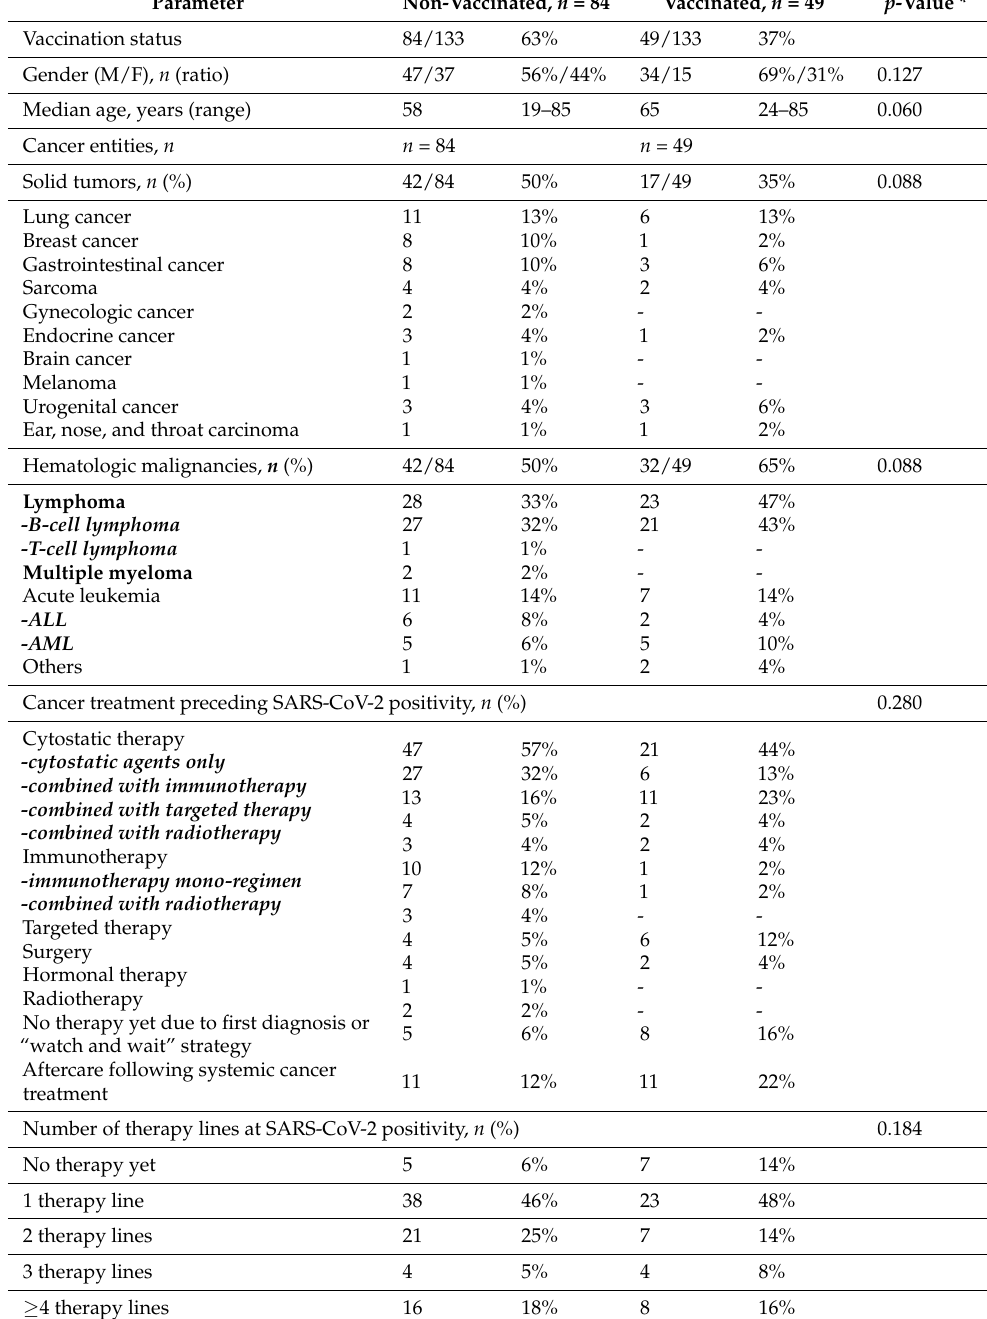
in Supplementary Table S1. In total, 77% ( n = 37/49) of the vaccinated patients had received mRNA-based COVID-19 vaccines. Another 10% ( n = 5/10) had either vector- followed by mRNA-based (8%) or vector-based (2%) vaccines only. Of the remaining cases, 11% ( n = 6/49) were double-vaccinated but lacked data on vaccine type documented in medical records. One patient (2%) received Ad26.COV2.S only one time. Seventeen vaccinated patients (35%) had received a third, mRNA-based, vaccine. The median time from the last vaccination to SARS-CoV-19 detection was 129 days. Table 1. Clinical characteristics of 133 cancer patients at the time of SARS-CoV-2 infection. M, male; F, female; n, number; ALL, acute lymphoblastic leukemia; AML, acute myeloid leukemia; PNH, parox- ysmal nocturnal hemoglobinuria; ITP, immune thrombocytopenia; MDS, myelodysplastic syndrome. Parameter Non-Vaccinated, n = 84 Vaccinated, n = 49 p -Value * Vaccination status 84/133 63% 49/133 37% Gender (M/F), n (ratio) 47/37 56%/44% 34/15 69%/31% 0.127 Median age, years (range) 58 19–85 Cancer entities, n n = 84 11 8